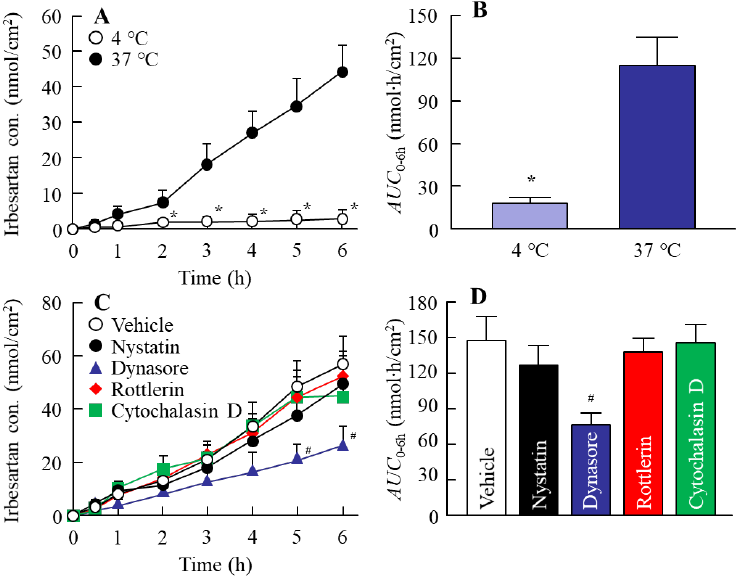
Figure 4. Effect of endocytosis inhibitor on the in vitro intestinal penetration of the IRB-NC suspensions. ( A , B ) Penetration profile ( A ) and AUC 0–6h ( B ) of irbesartan in the IRB-NC suspensions under 4 or 37 °C conditions. ( C , D ) Drug penetration profile ( C ) and AUC 0–6h ( D ) of the IRB-NC suspensions in the intestines of rats treated with endocytosis inhibitors. 4 °C, IRB-NC-suspension-treated intestine at 4 °C. 37 °C, IRB-NC-suspension-treated intestine at 37 °C. Vehicle, intestine cotreated with IRB-NC suspensions and a vehicle of endocytosis inhibitors (0.5% DMSO). Nystatin, intestine cotreated with IRB-NC suspensions and nystatin. Dynasore, intestine cotreated with IRB-NC suspensions and dynasore. Rottlerin, intestine cotreated with IRB-NC suspensions and rottlerin. Cytochalasin D, intestine cotreated with IRB-NC suspensions and cytochalasin D. n = 5–9. * p < 0.05 vs. 37 °C group for each category. # p < 0.05 vs. vehicle for each category. The intestinal penetration of the IRB-NC suspensions was attenuated by treatment with dynasore.